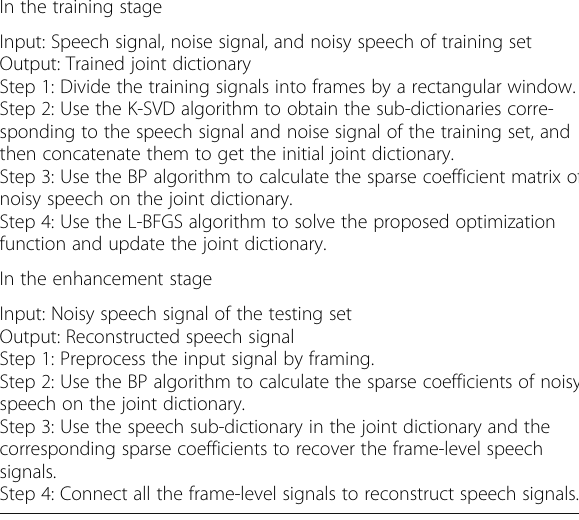
Table 1 Detailed process of the proposed speech enhancement